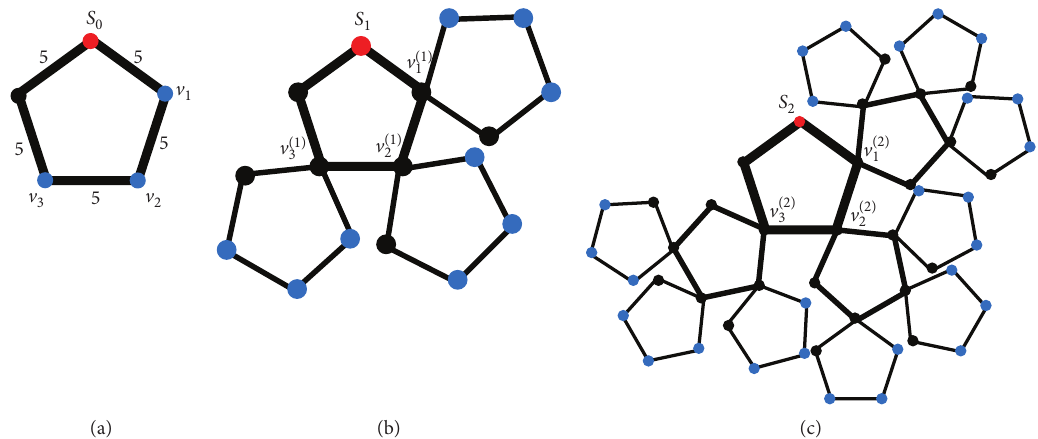
Figure 1: From the left to the right, G denotes the beginning node, and the blue points of G i denote the end nodes. Set f weights: the thicker the line, the larger the